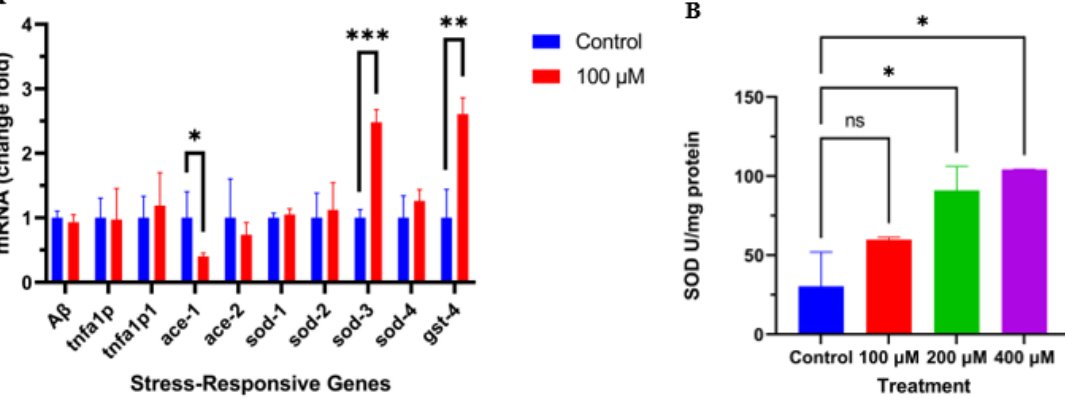
Figure 4. Caesalmin C improves the resistance of C . elegans to oxidative stress. ( A ) The effect of caesalmin C on the expression level of stress-responsive genes in CL4176 worms. β-actin was used as an internal reference. ( B ) The effect of caesalmin C on the SOD activity in CL4176 worms. In all of the above, 0.1% ( v / v ) DMSO was used as control. Data are expressed as mean ± SD. The asterisk indicates significant difference compared to the respective control (ns p > 0.05, * p < 0.05, ** p < 0.01, *** p < 0.001).